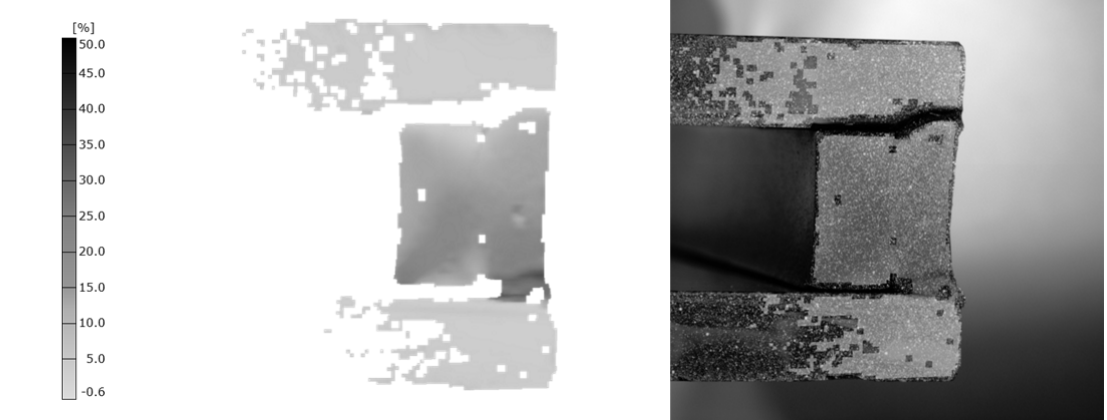
Fig. 17 Ködispace 4SG edge compound of an IGU model after applying a load in normal direction with stochastic pattern and derived major